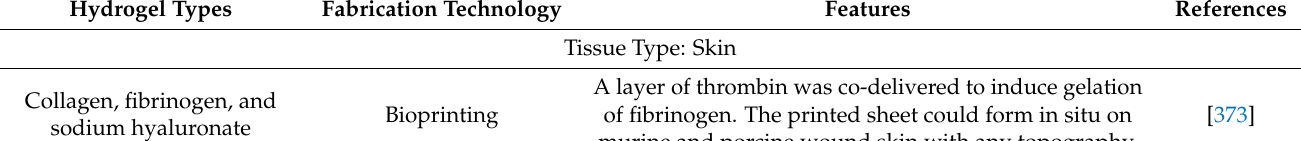
Table 4. Selected survey on hydrogel types and fabrication technology used in in vitro models of various tissue